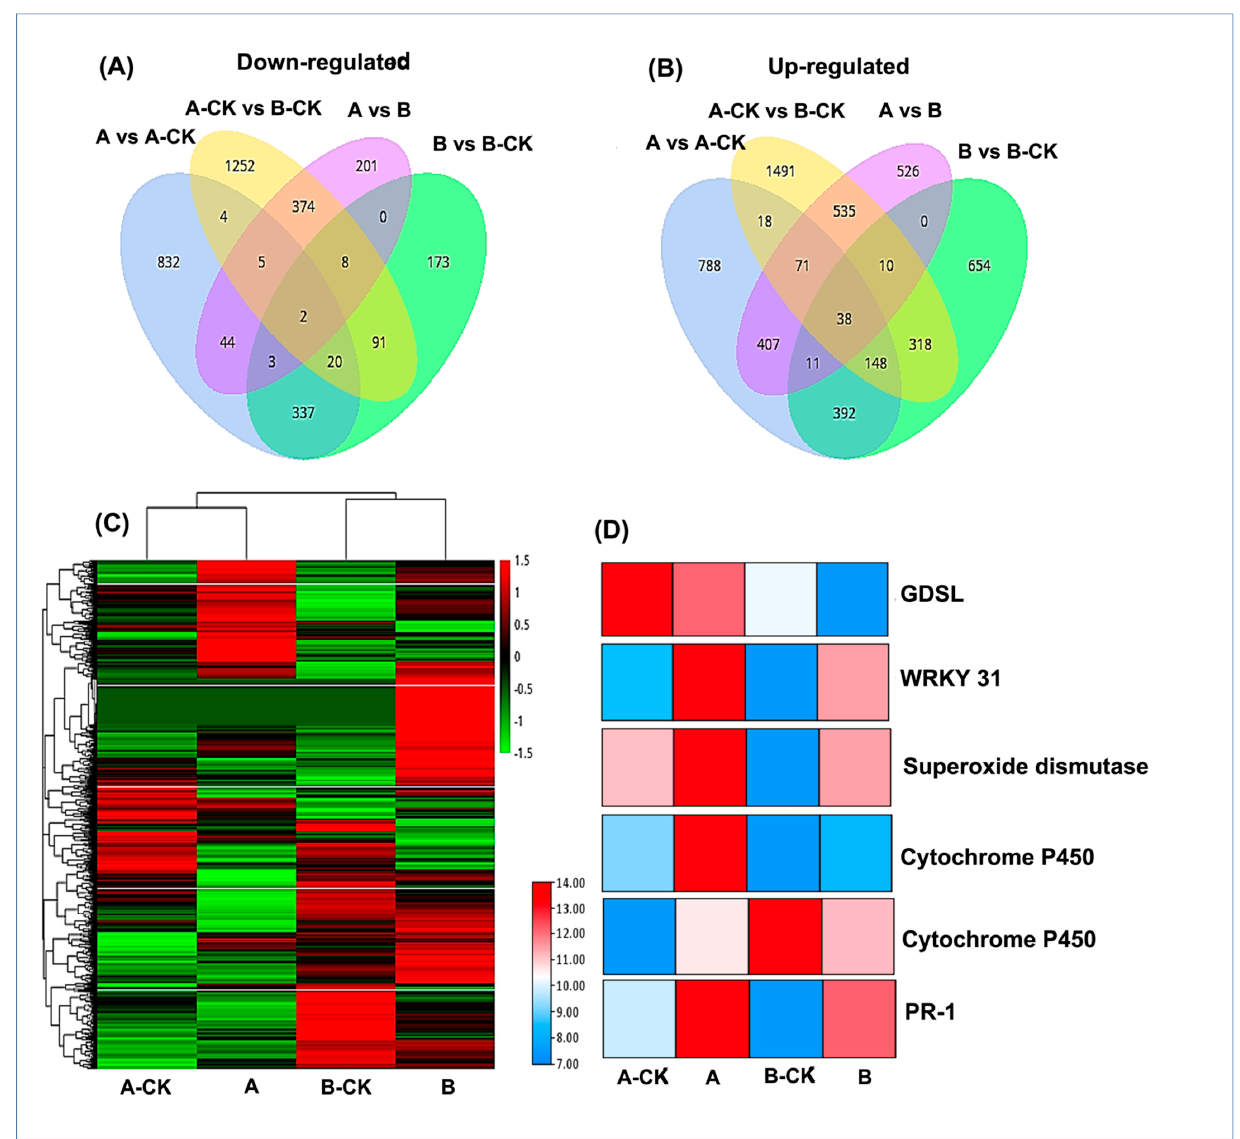
Figure 2. ( A , B ) show the distribution of up and down regulating differentially expressed genes (DEGs) in different comparison groups of resistant Dawei ( A ) and susceptible Qiuxiang ( B ) of hazelnuts after B. cinerea Z9 infection. ( C ) Heat map showing the expression level of DEGs in all groups. Red color indicates higher expression and green color indicates lower expression. ( D ) Commonly expressed potential key genes involve in resistance to B. cinerea . Treatments: A-CK (Dawei-un-inoculated control), A (Dawei- inoculated with B. cinerea ), B-CK (Qiuxiang-un-inoculated control), B (Qiuxiang- inoculated with B. cinerea